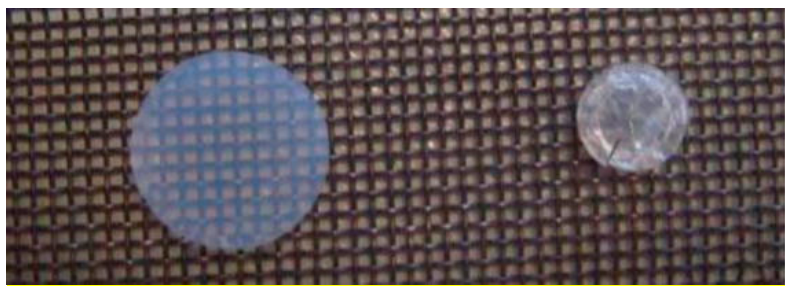
Figure 4. Silica gel images obtained by supercritical drying ( left ) and ambient drying ( right ). Reprinted with the permission from [21].